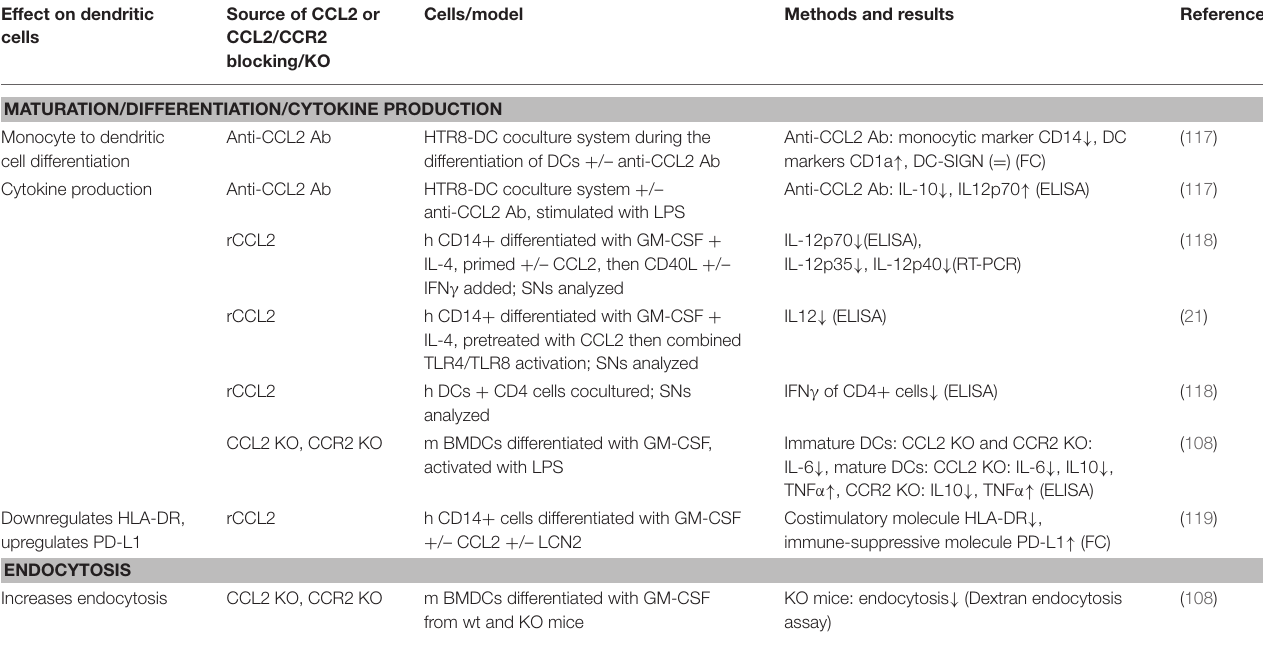
TABLE 4 | Summary of CCL2’s effects on dendritic